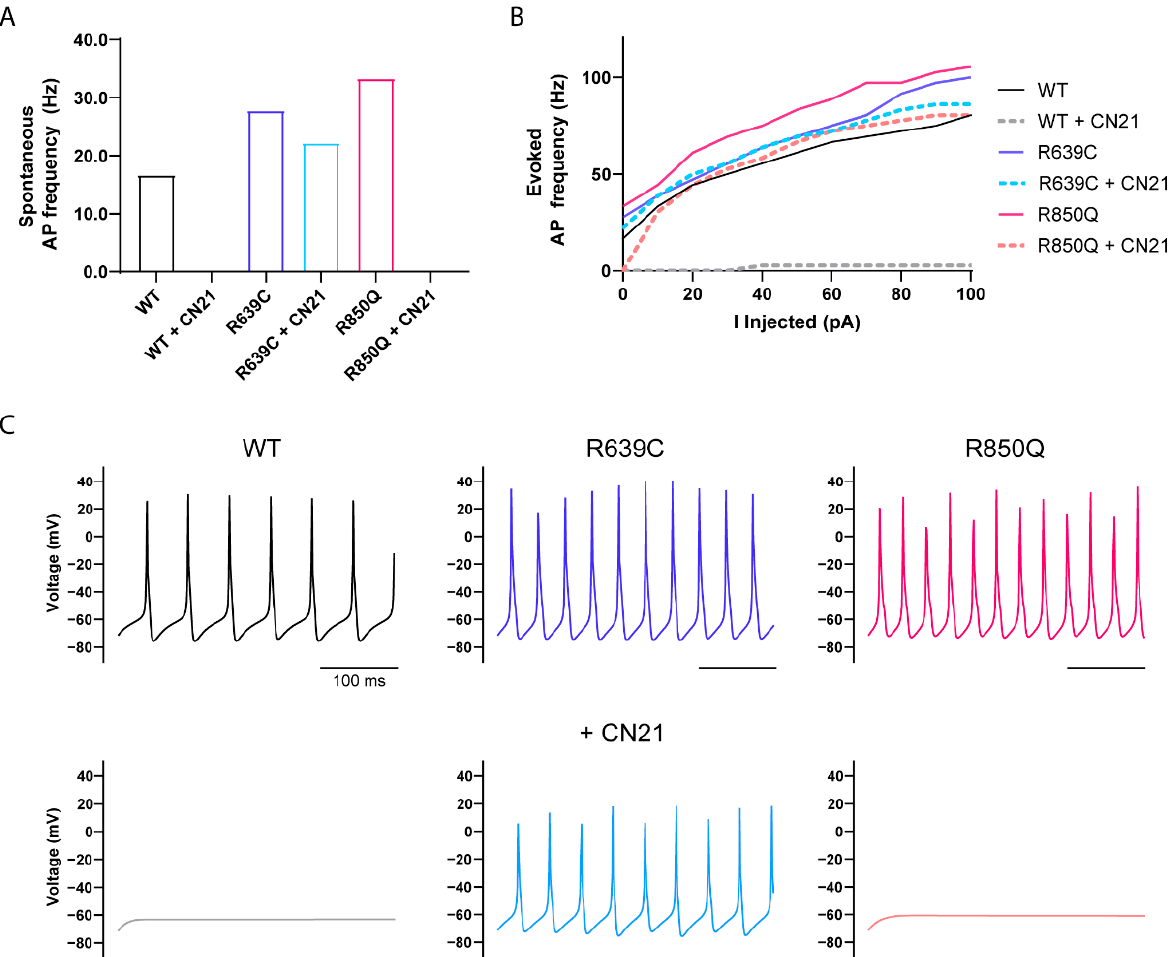
Figure 9. Simulations of action potential firing in a Purkinje neuron expressing heterozygous mutant Nav1.6 channels with and without CaMKII inhibition. Quantification of spontaneous ( A ) and